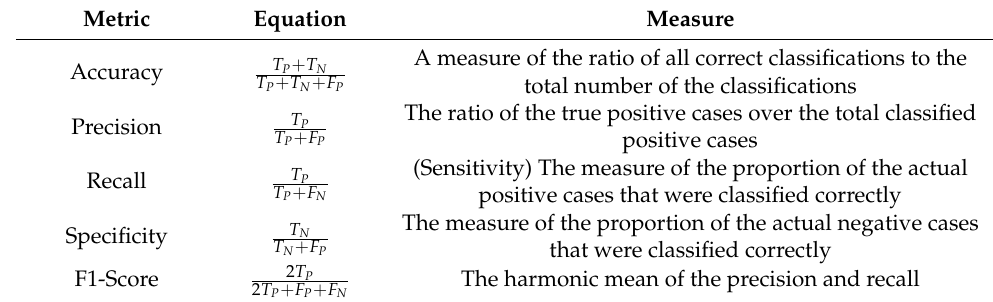
Table 2. Metric Equations and explanation.